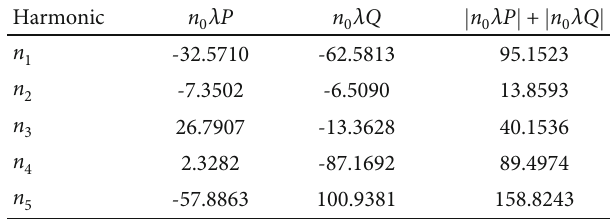
Figure 3: Behavior of sine terms, cosine terms, the Fourier fi t (without A correspond to the i th harmonic n i , i = 1, 2, ⋯ , 5 . Table 2: Parameters λ and n Harmonic